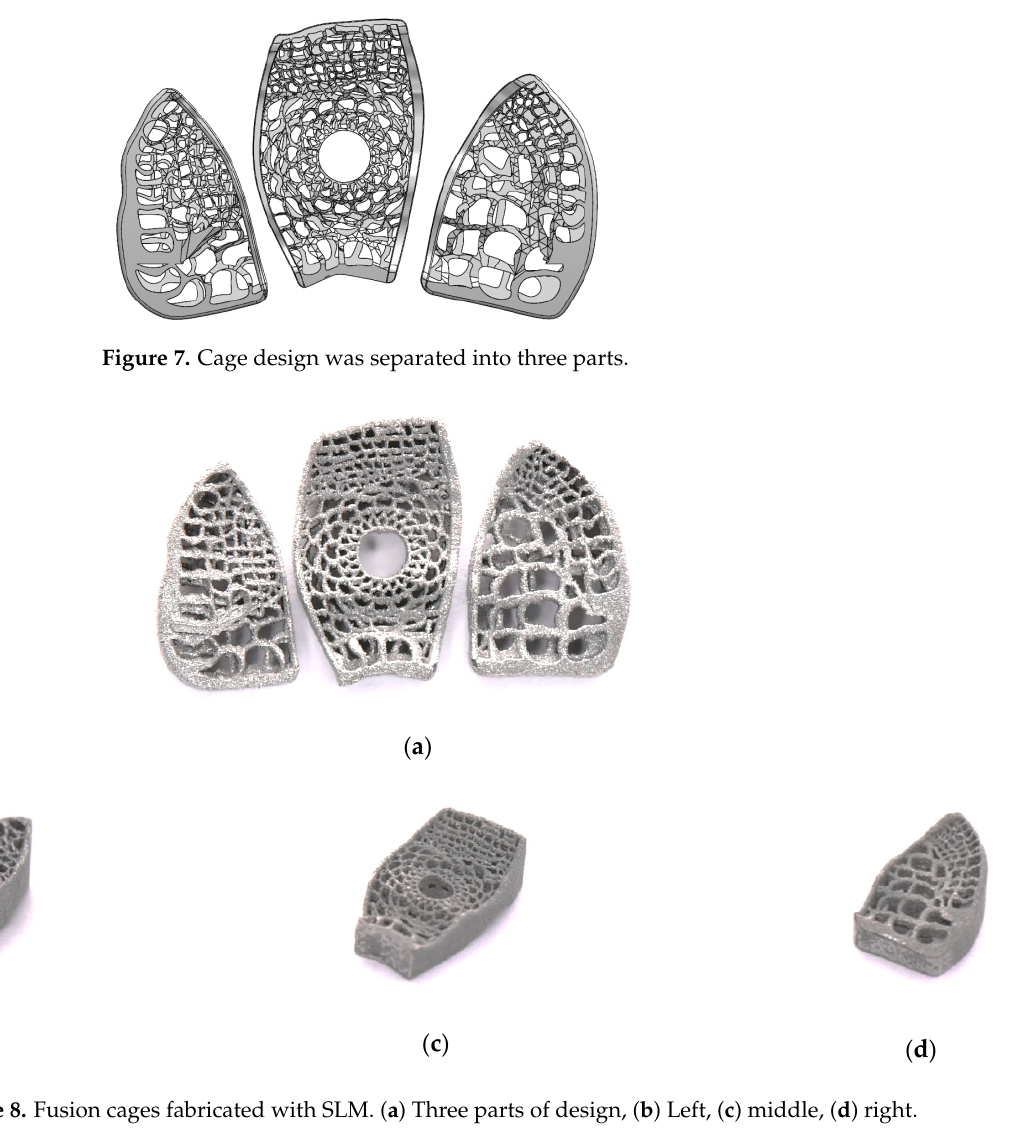
Figure 10. The optical microscope (OM) photograph for specimens. Table 2. Dimensions of the left part of the cage. (a)